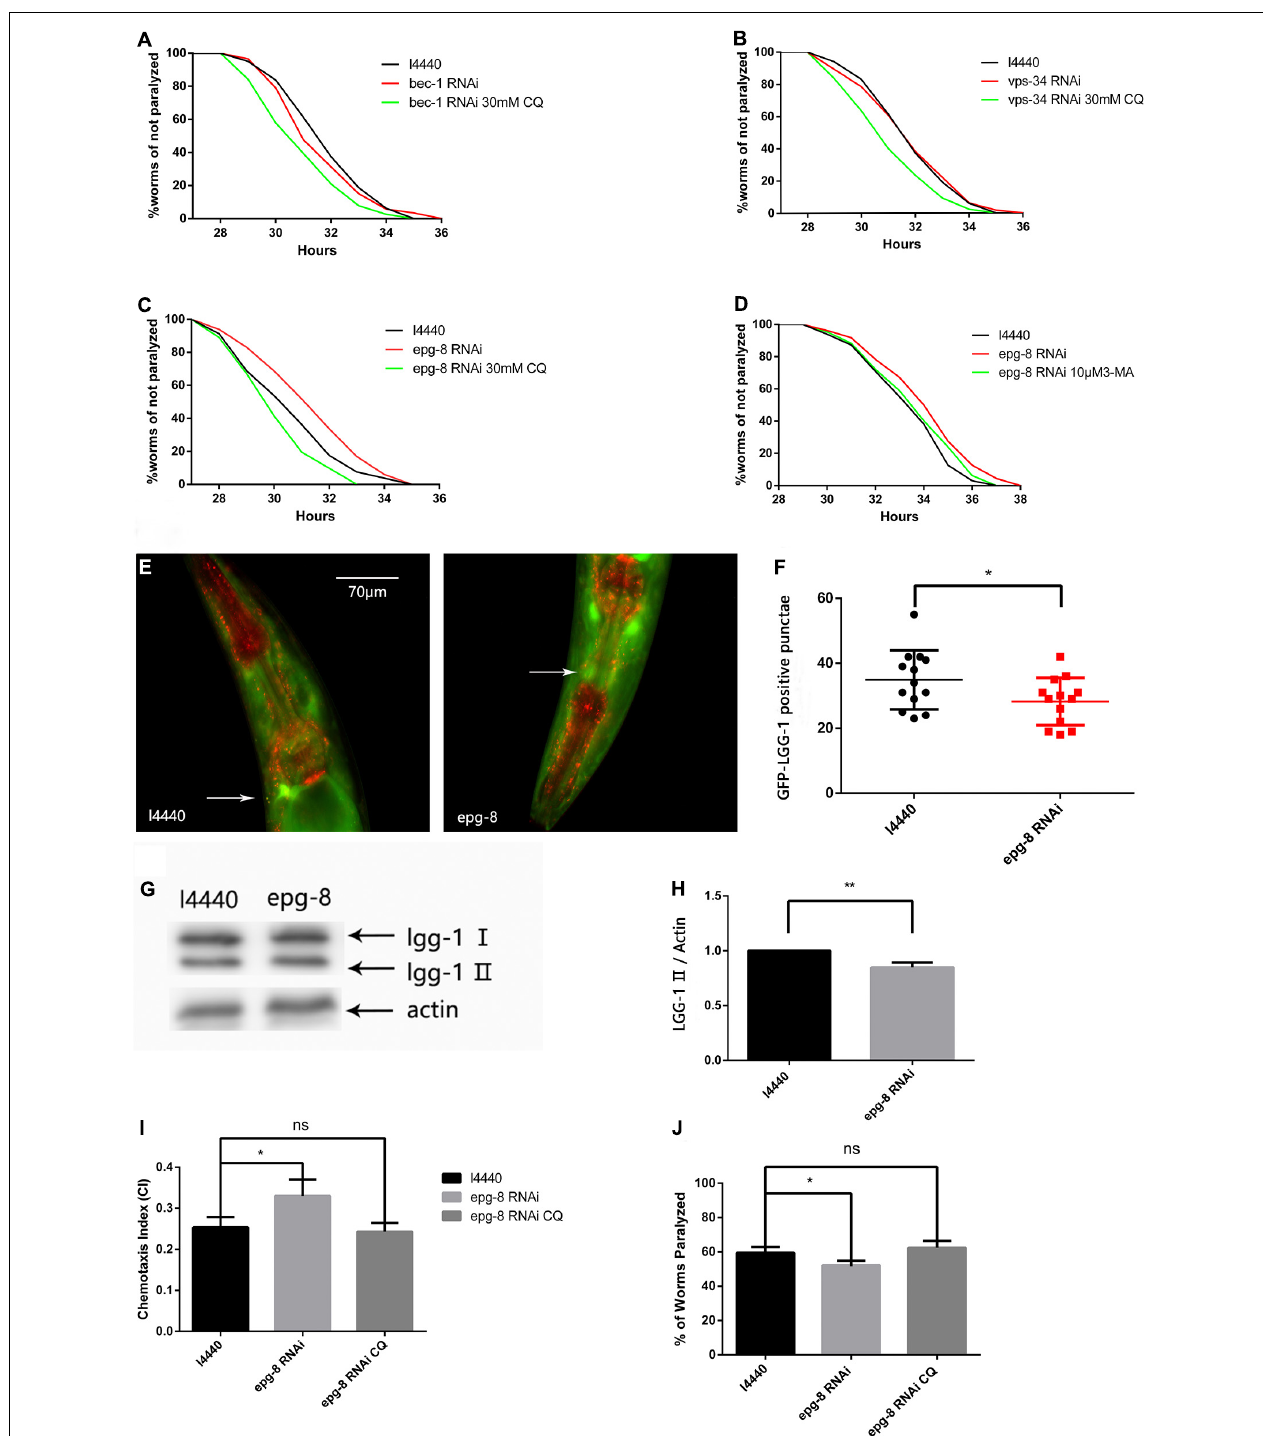
FIGURE 4 | The CL4176 strain was fed either vector l4440 control bacteria or bacteria expressing RNAi for bec-1 (A) , vps-34 (B) , or epg-8 (C,D) . RNAi of epg-8 delayed A β -induced paralysis which could be offset by CQ. ( n = 3, * p < 0.05 by the log-rank test). Each individual group contains more than 30 nematodes. (E) Punctae formation in the GMC101 strain with or without RNAi bacteria as shown by fluorescence microscopy. (F) Scoring of punctae with or without RNAi bacteria ( n = 13 per group, * p < 0.05 by the Student’s t -test). (G) Representative western blot of mCherry::GFP::lgg-1. (H) Quantified western blot gel intensities, as determined by ImageJ software ( n = 3, ** p < 0.01 by the Student’s t -test). (I) Chemotaxis of the CL2355 strain fed either vector l4440 control bacteria or bacteria expressing RNAi for epg-8 . (J) Serotonin hypersensitivity was restored by epg-8 RNAi and reversed by CQ. Each group contains about 60 worms ( n = 3, * p < 0.05).